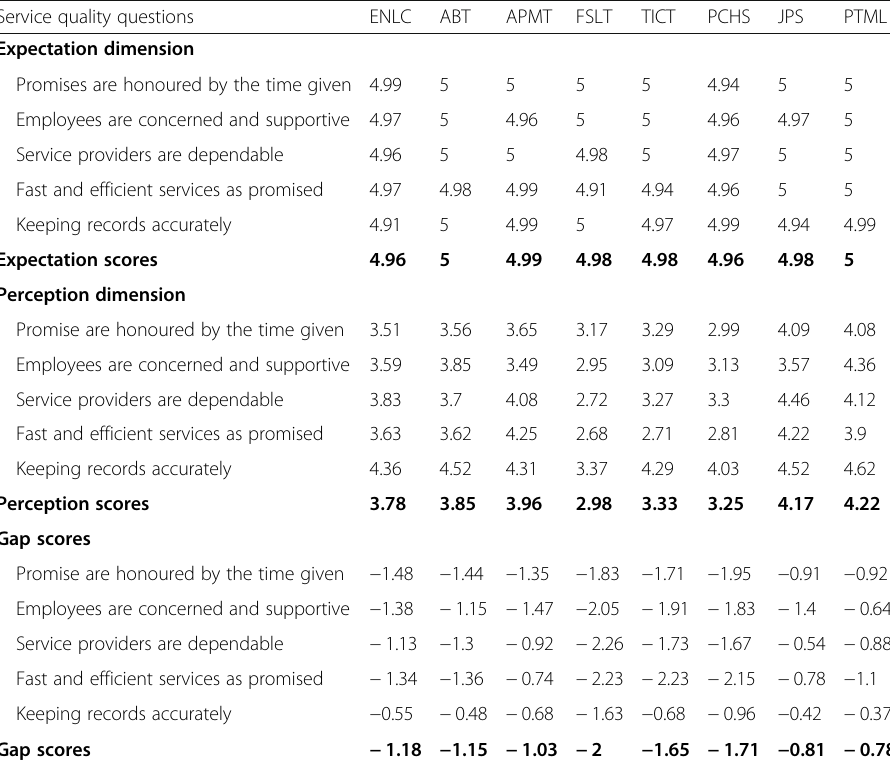
Table 5 Service quality expectation and perception average scores for reliability Service quality questions ENLC ABT APMT FSLT